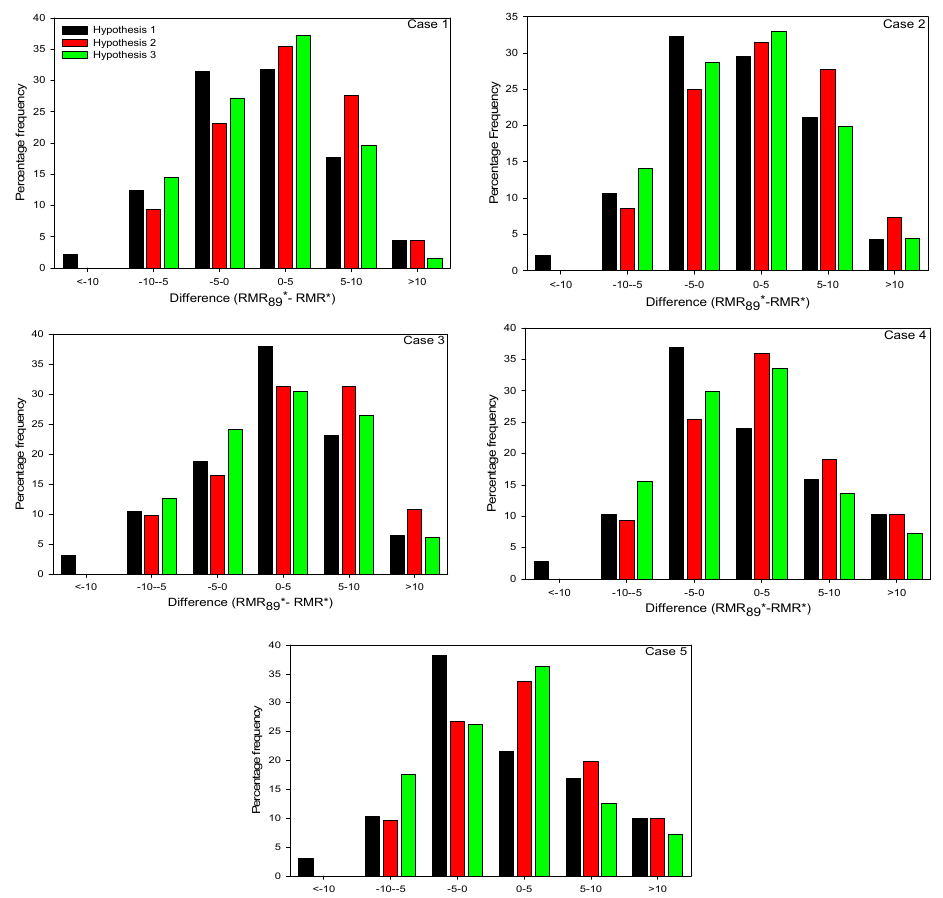
Figure 3. Effect of weightage (Table 6) during back-calculation of rock-mass quality ( RMR *) (Figure 1) in terms of difference between stress-adjusted RMR 89 ( RMR 89 *) and RMR * using hypothesis of Table 3.